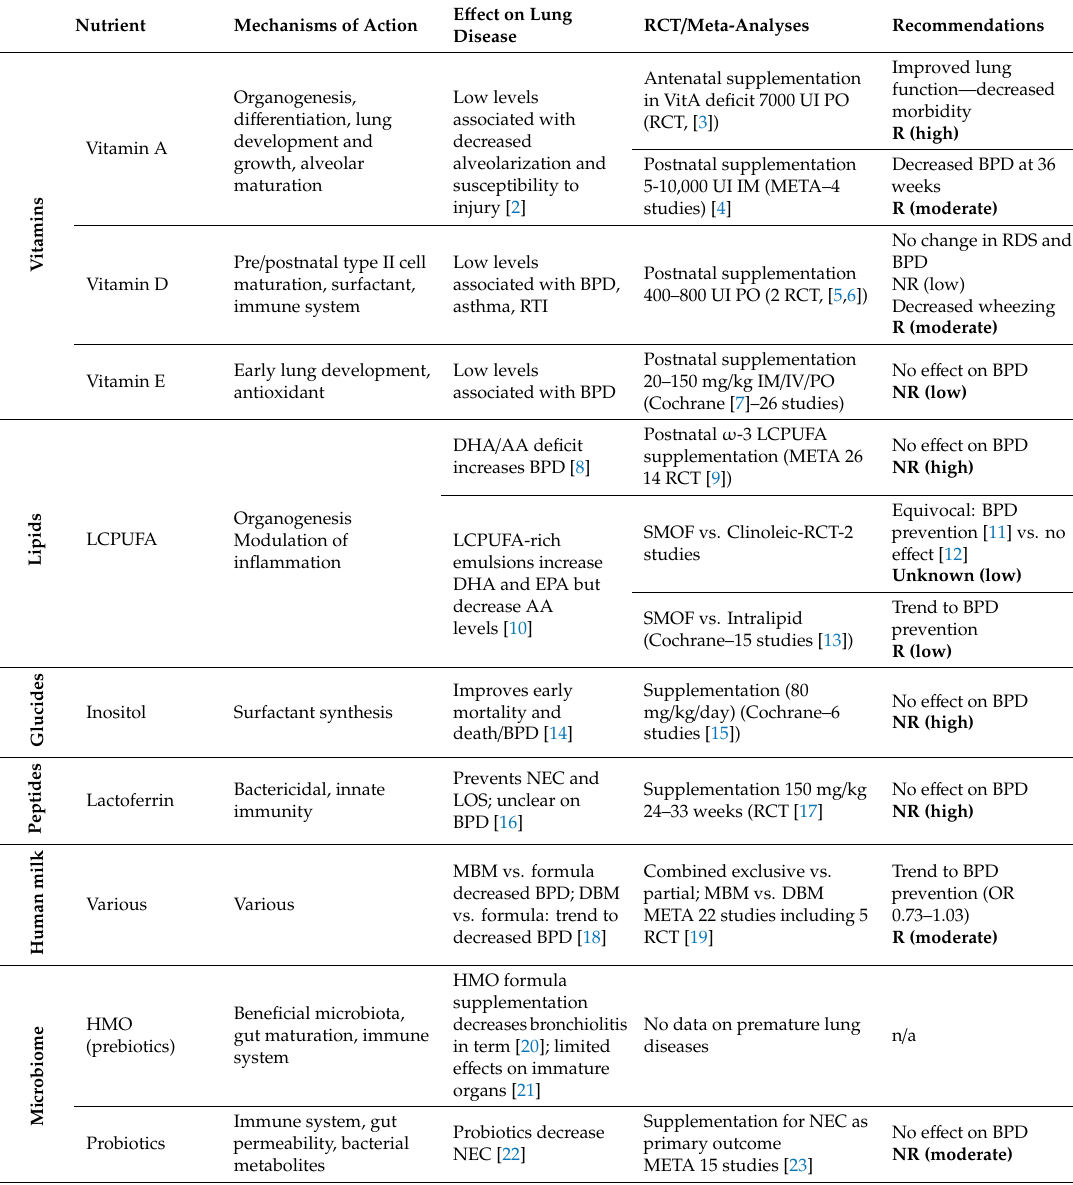
Table 1. Evidence-based recommendations on selected nutrients for premature lung disease